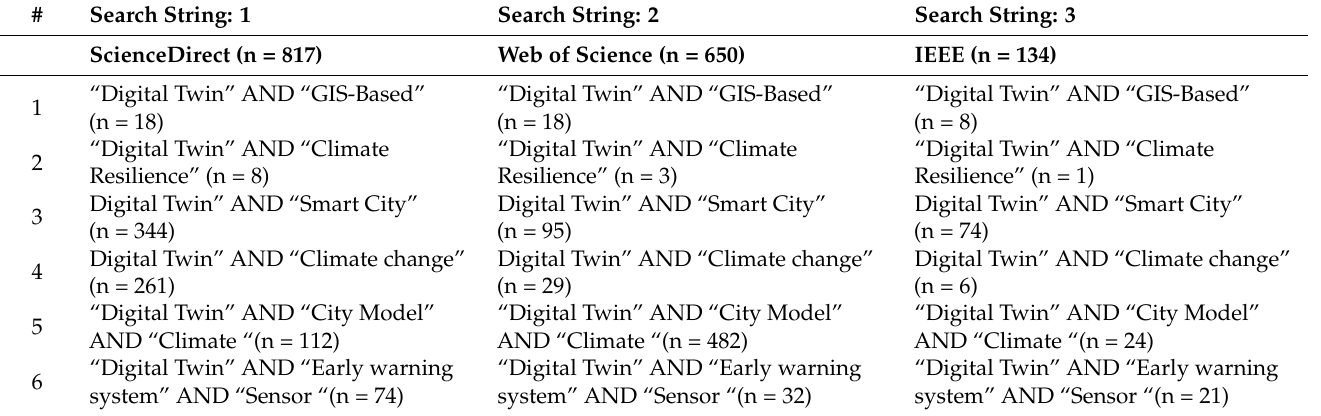
Table 1. List of search queries conducted in this